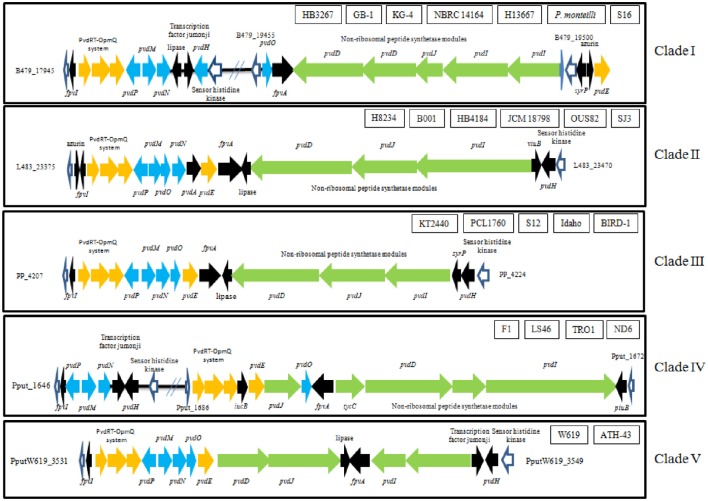
Organization of the pyoverdine locus in representative P. putida strains of every clade found. Green arrows symbolize genes involved in non-ribosomal peptide synthesis modules, yellow/orange arrows indicate genes involved in pyoverdine transport or recycling, blue arrows indicate genes involved in pyoverdine maturation, black arrows other genes involved in pyoverdine biosynthesis and white arrows are genes not directly involved in pyoverdine biosynthesis. Genes without a name, no specific function was found.